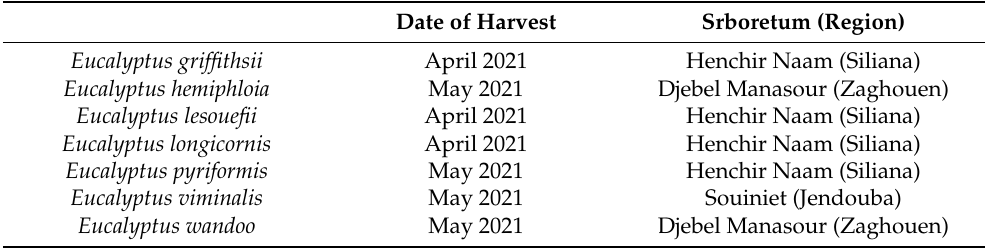
Table 6. Date and place of harvest of samples.